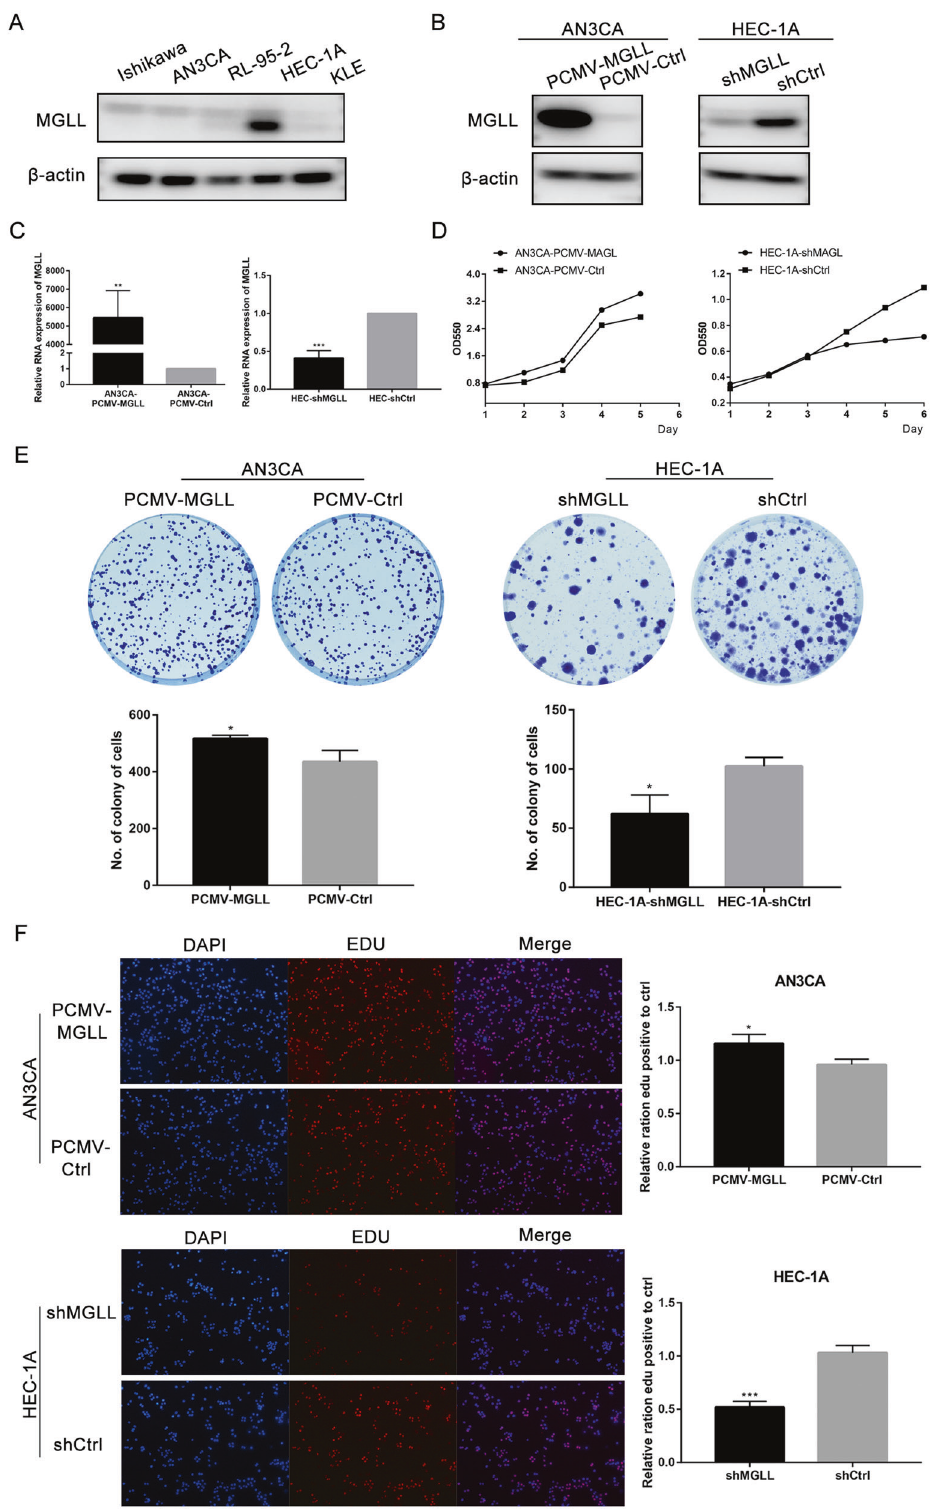
Fig. 2 MGLL promotes the proliferation and inhibits the apoptosis of EAC cells. A Expression of MGLL in Ishikawa, AN3CA, RL95-2, HEC-1A and KLE cells. B Protein level of MGLL in AN3CA cells after MGLL knockdown and in HEC-1A cells after MGLL overexpressed. C mRNA level of MGLL in AN3CA cells after MGLL knockdown and in HEC-1A cells after MGLL overexpressed. D Growth curves of cells after MGLL deletion or overexpression compared with control cells. E The effect of MGLL overexpression and inhibition on colony formation. F Proliferation rates of cells overexpressing or knocking-out MGLL by EDU incorporation assay. G Proportion of apoptotic cells presented by apoptosis assay in cells after overexpression or knockdown of MGLL. H Expression of CDK4, CyclinD1, Bcl-2, cleaved-PARP and cleaved-caspase3 were determined by Western blot assay in EAC cells after overexpression or knockdown of MGLL. All experiments were repeated three times at least. * P < 0.05, ** P < 0.01, *** P < 0.001 and **** P < 0.0001 for statistical analysis of the indicated groups. Cell Death and Disease (2022)